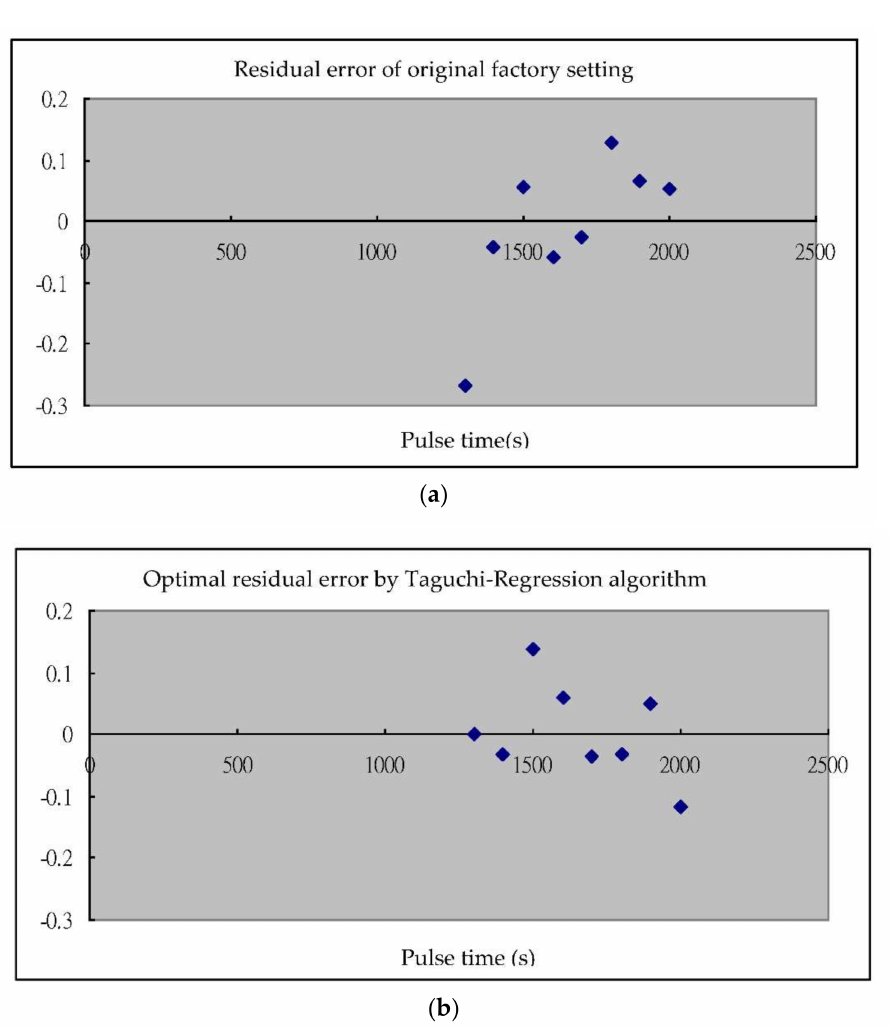
Figure 14. ( a ). Residual error of factory setting for the fuel injection test; ( b ). optimal residual error of injection test by the Taguchi-Regression